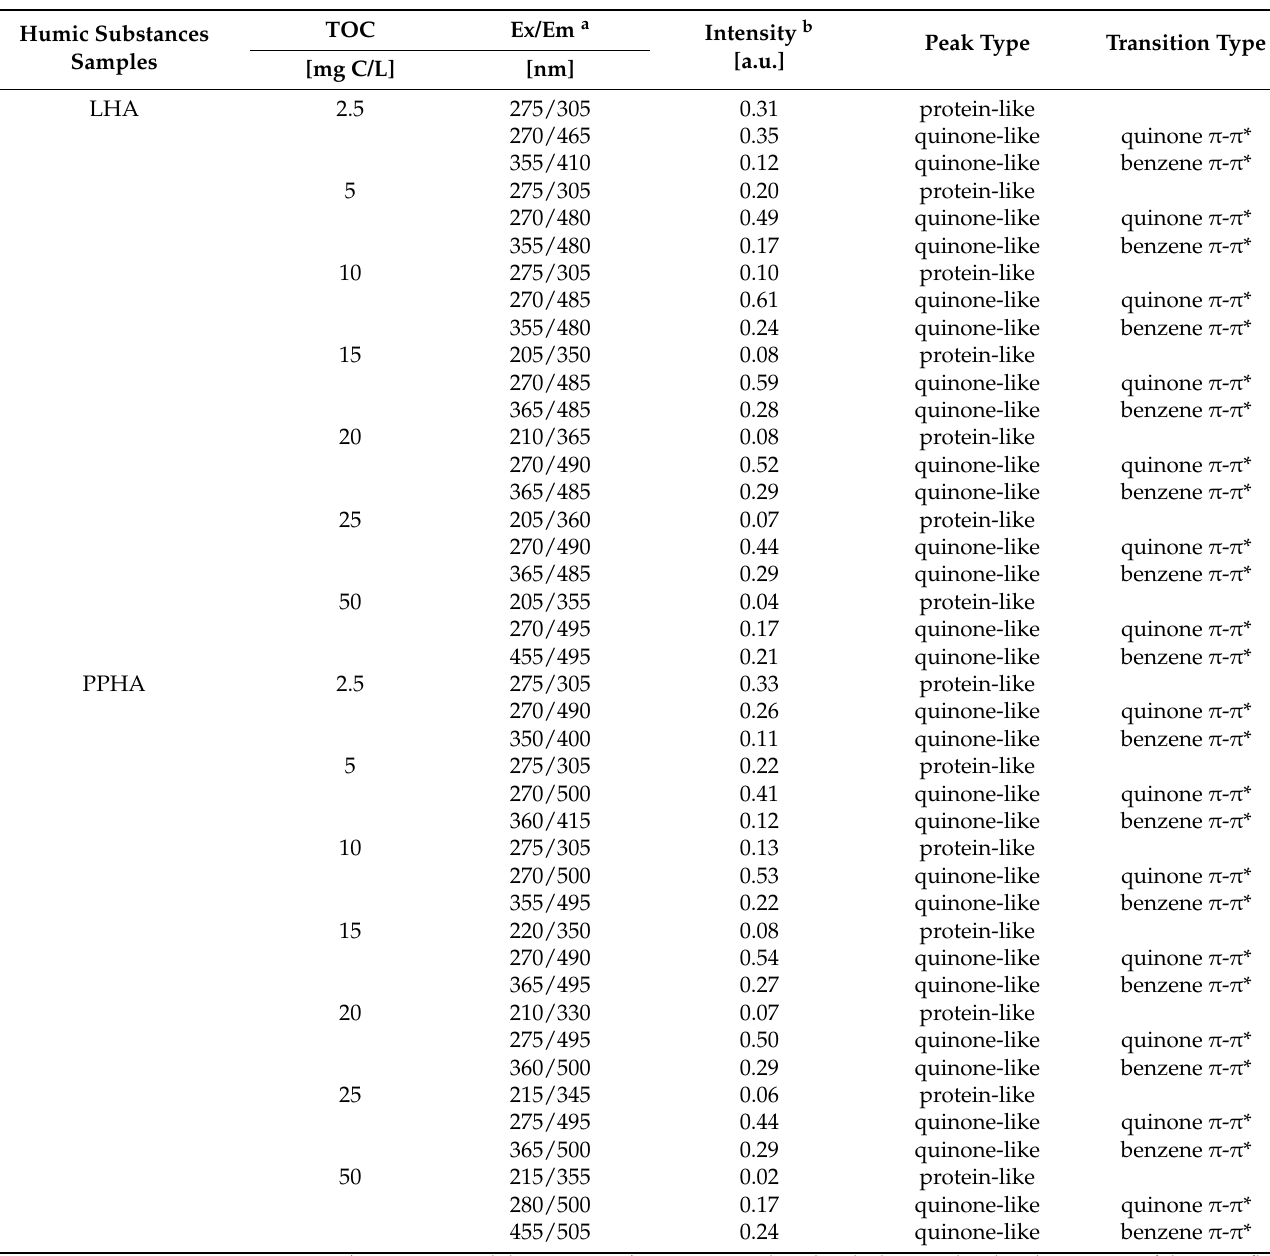
Table 1. Fluorescence peak positions and relative fluorescence intensities of PPHA and LHA with different TOC